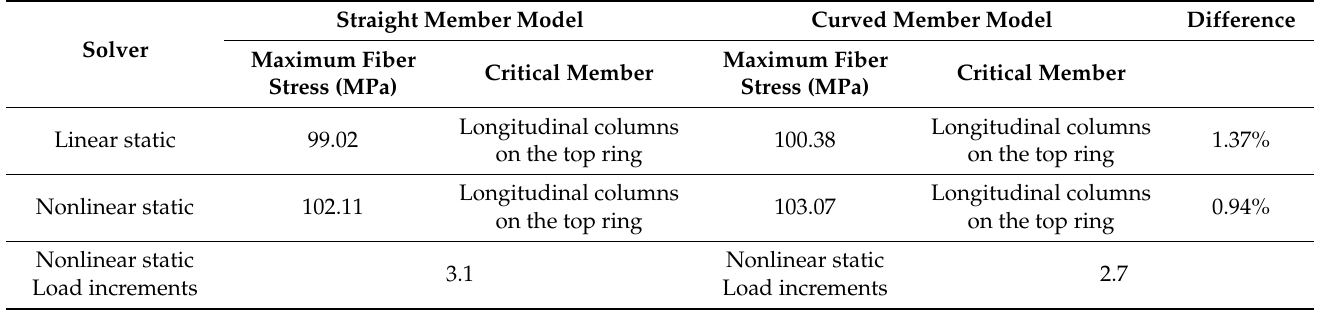
Table 6. Fiber stresses under 1.35G.